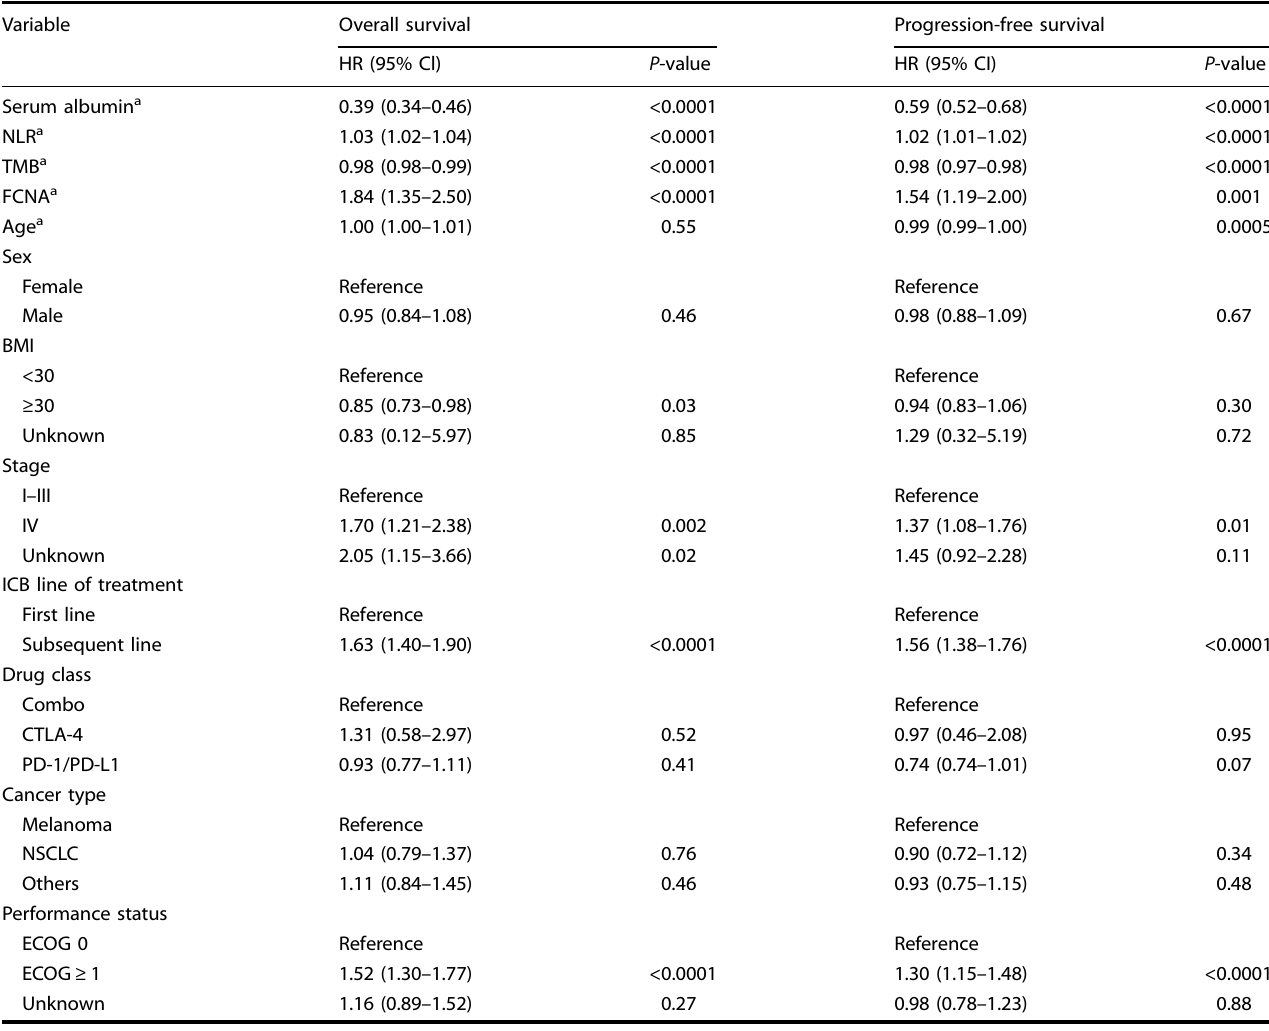
Table 1. Result for multivariable Cox regression